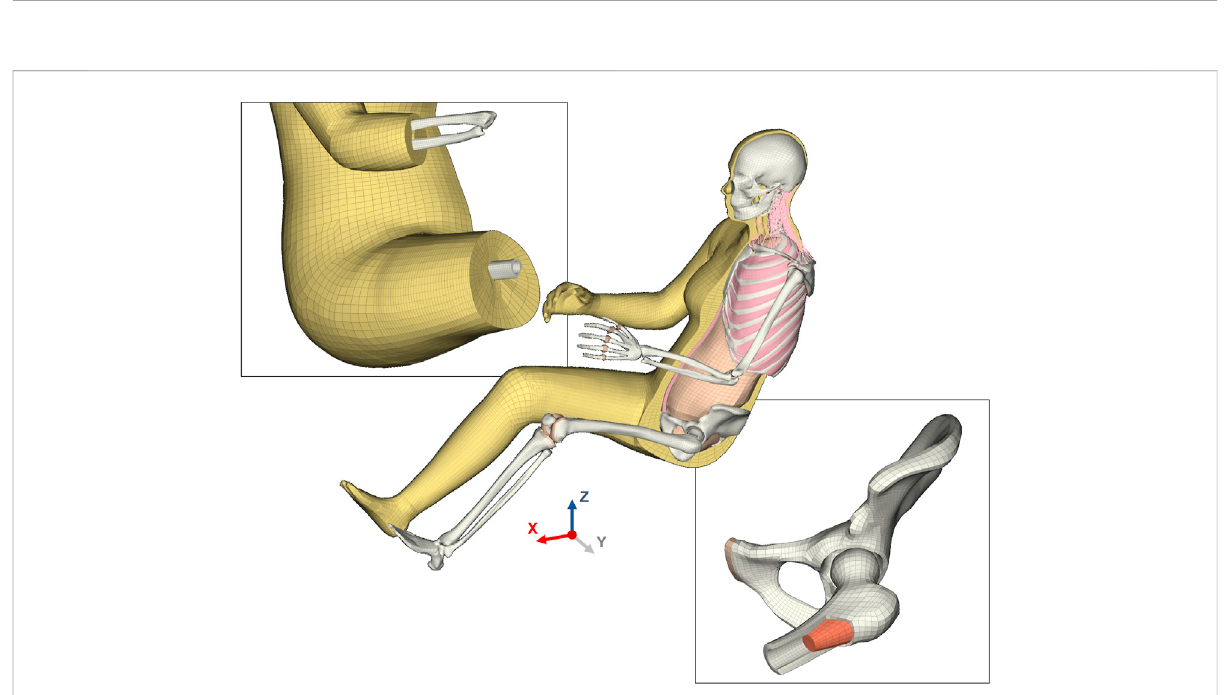
FIGURE 2 Finite element mesh design of the VIVA + base model. The top-left inset shows the fl ow of the soft tissue mesh intended to maintain a good mesh quality in all postures ranging from seated to standing. This inset also shows the soft tissue mesh that is nodal connected to the long bones in thelowerextremity.Thebone-softtissueinterfacewasnotde fi nedwithnodalconnectivityintheupperextremitybutinsteadde fi nedwithcontacts. The bottom-right inset is an illustration of the hexahedral mesh in the skeletal structure of the model. The cut-section of the femur shows the solid cortical and trabecular mesh, with cortical bone transitioning from 3-element to 1-element mesh towards the thinner cortical regions in the femur